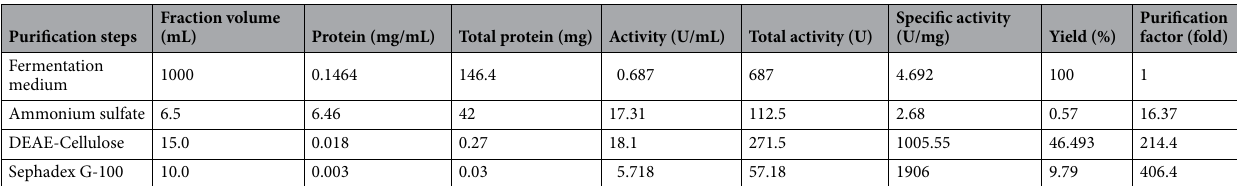
Table 2. Purification profile of pure pectinase produced by C. parasphaerospermum AUMC 10865 at pH 6.0 and 10 °C in SmF.